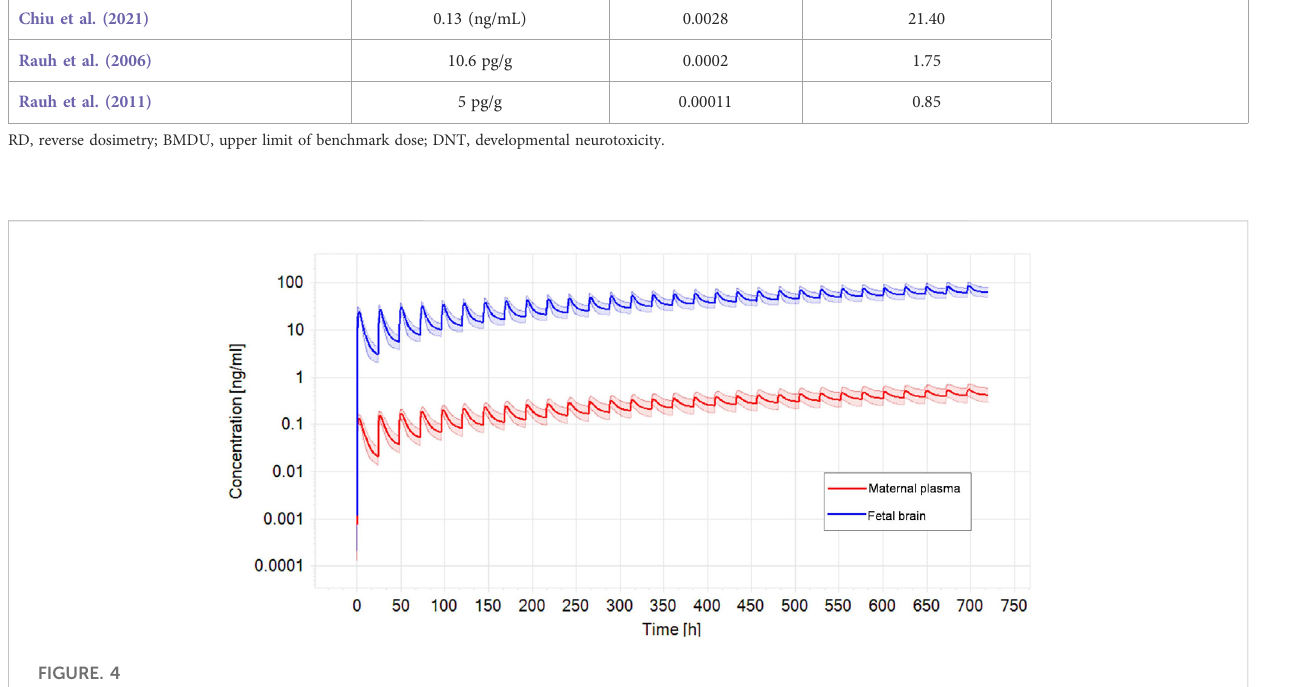
FIGURE. 4 Optimized dose trial in reverse dosimetry for 0.56 ng/mL CPF plasma concentration in the mother according to Silver et al. (Silver et al., 2017) after 1 month repeated oral exposure in a population of pregnant women (N = 100). Solid line represents simulated mean CPF pro fi le while shaded areas denotes the predicted 95% con fi dence